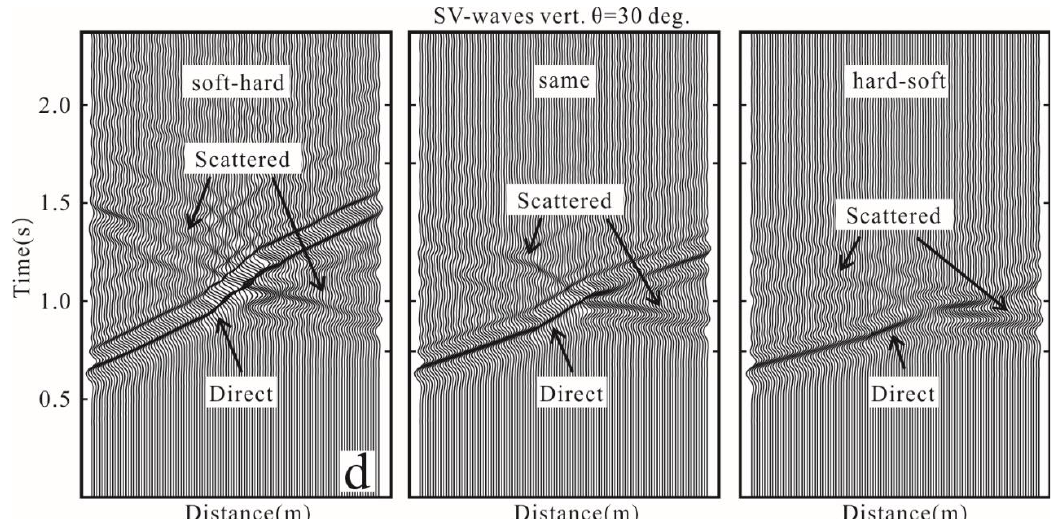
Figure 17. Synthetic accelerogram (accelerations recorded along the ground with time) generated along the topographic profile, plotted from the horizontal or vertical components of P waves and SV waves arriving from the left of the model at incident angle of 30°. ( a ) horizontal P waves with 30 ° directions, ( b ) vertical P waves with 30 ° directions, ( c ) horizontal SV waves with 30 ° directions ( d ) vertical SV waves with 30 ° directions.